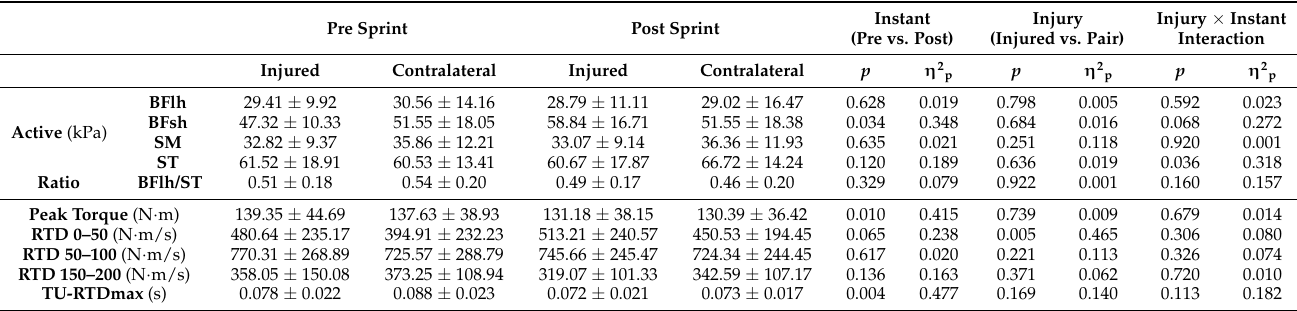
Table 4. Acute effects of a sprint protocol in limbs with biceps femoris long head injury history (n = 14) vs. healthy contralateral limbs (n = 14) on the active shear modulus and neuromus- cular